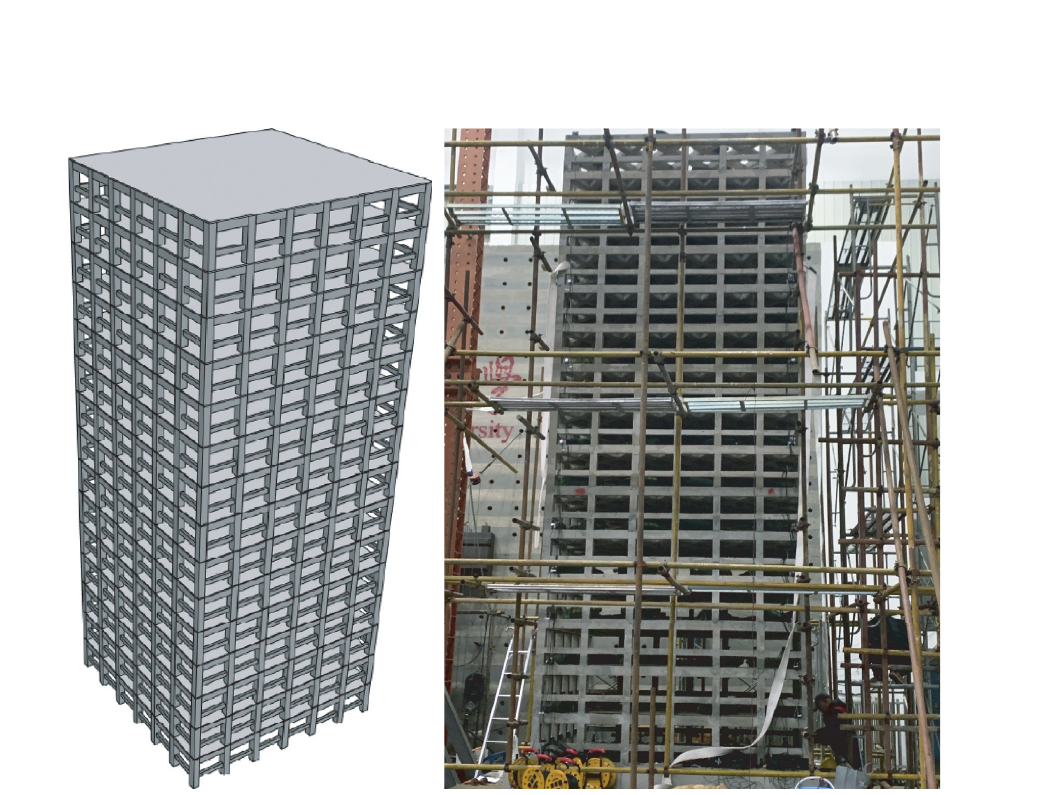
Figure 9: Structure model applied in the experiment.